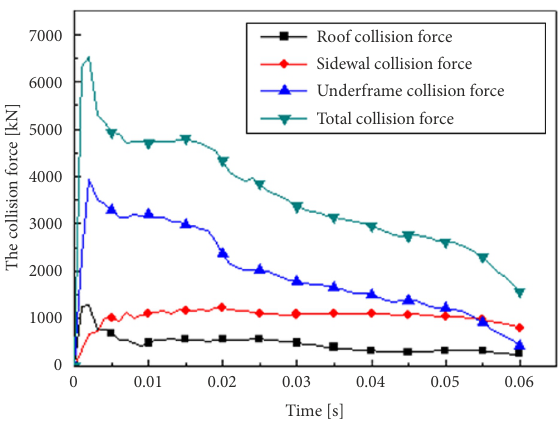
Figure 7. Transfer characteristic curve of the collision force